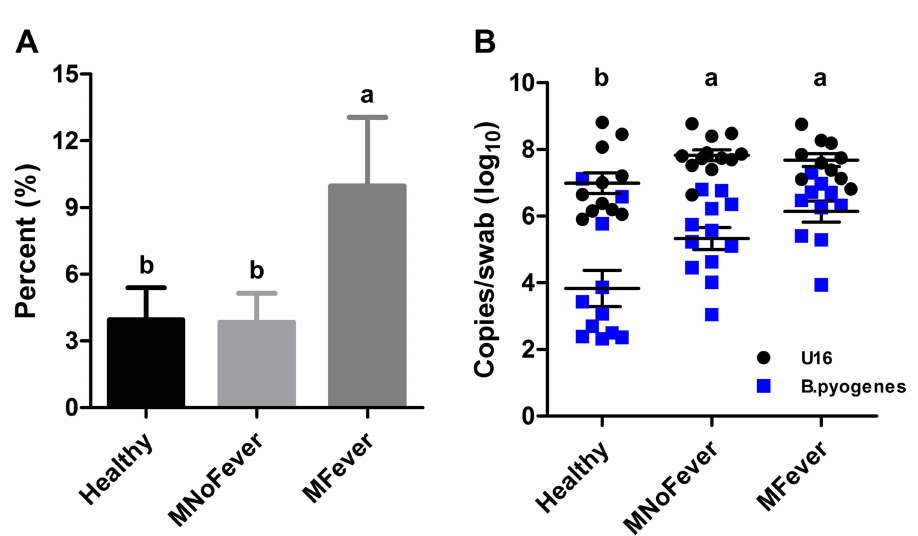
Fig 4. Associations of Bacteroides pyogenes with a fever. (A) Relativeabundanceof B . pyogenes based on metagenomic sequencing. Bars represent the mean ± SEM. (B) Absolute abundanceof total bacteria and B . pyogenes based on droplet digital PCR. The log 10 number of total bacteria (black circles) and B . pyogenes (blue squares) were quantifiedin uterine swab samples using the 16S rRNA gene and recA gene, respectively. Each symbol represents an individualcow and error bars indicate the means ± SEM. Data labeled“a” are statistically different ( P (cid:20) 0.05) from data labeled“b”.